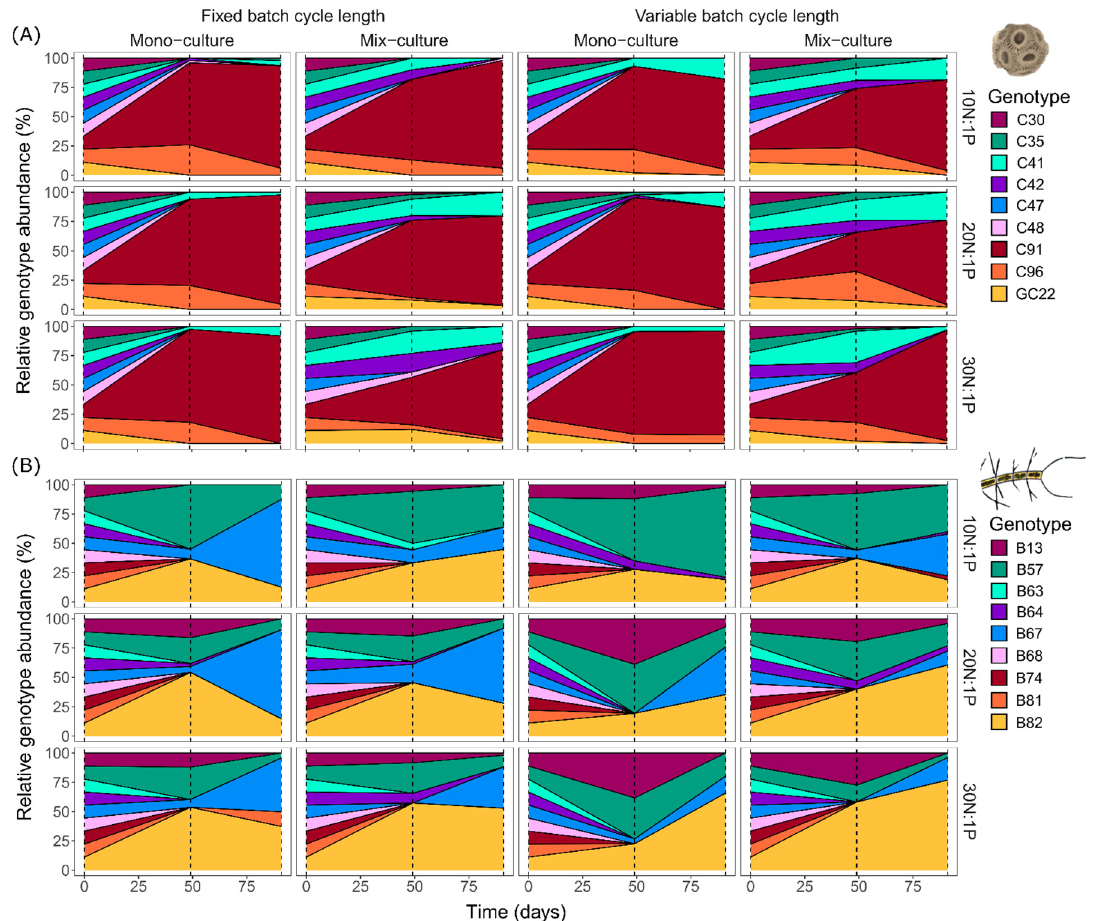
Figure 3. Mean relative genotype composition of E. huxleyi ( A ) and C. affinis ( B ) genotypes over time in mono-culture and mix-culture, at three nutrient regimes (10N:1P, 20N:1P, and 30N:1P) with fixed and variable batch cycle